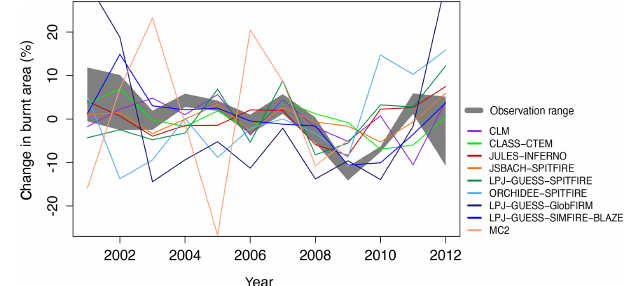
Figure 4. The range in interannual variability in burnt area for the years 2001–2012 for all models and burnt area datasets which span the entire time period (GFED4, GFED4s, MCD45, FireCCI51). Re- sults from the individual FireMIP models, as well as the observa- tional minimum-maximum values, are